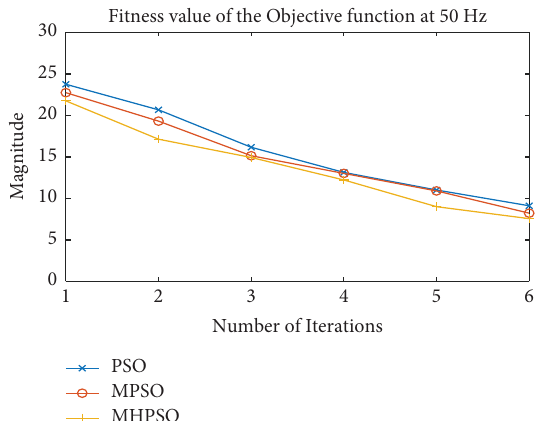
Figure 16: Tree methods of ftness value comparison at 50Hz. Figure 17: Tree methods of ftness value comparison at 5 Hz.